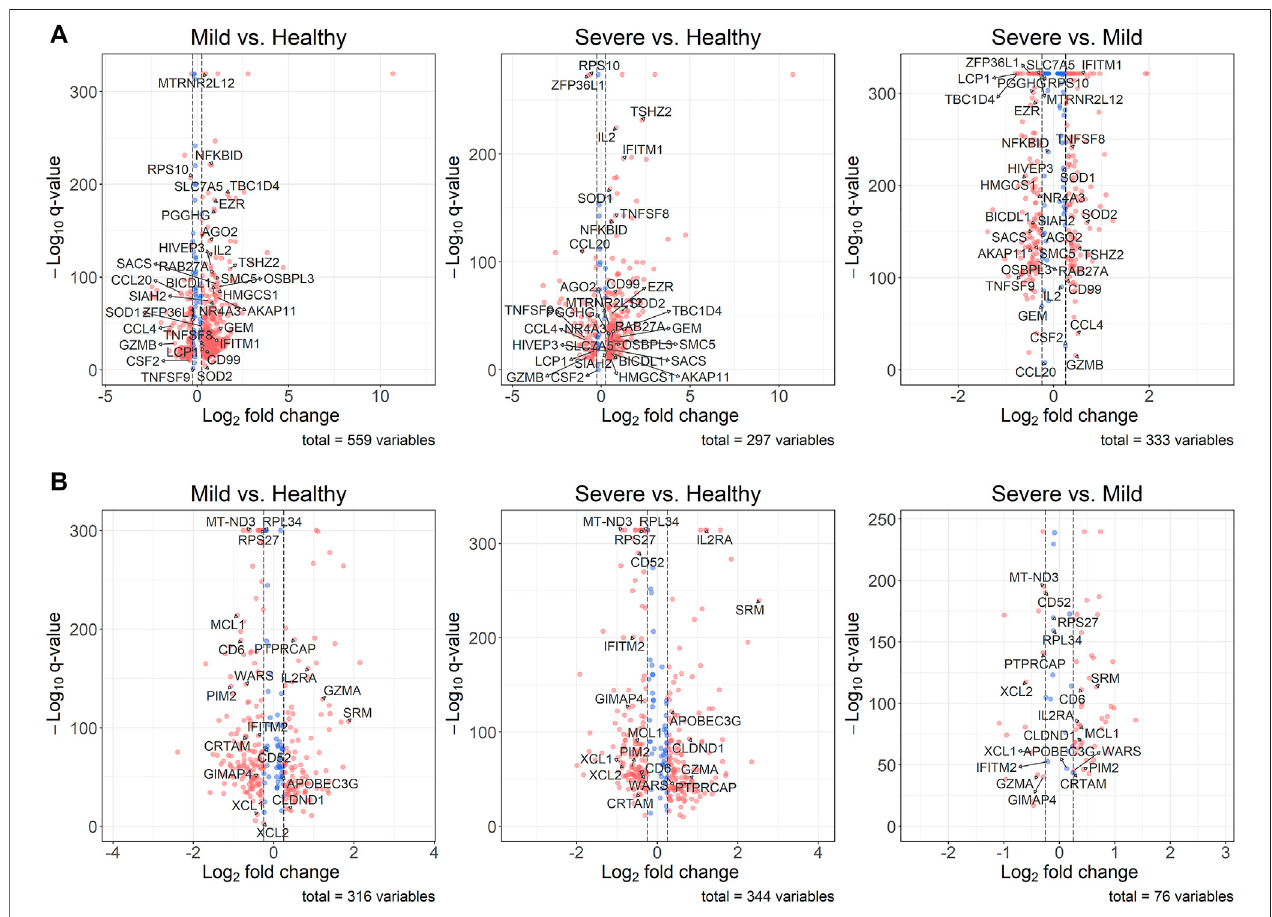
FIGURE3| VolcanoplotsforDEgenes.Thethresholdsoftheabsolutelog 2 FC is0.25 (A) ComparisonsbasedonCD4 + Tcells.DEgenes DDX3Y and EIF1AY have been removed from the mild vs healthy plot and the severe vs healthy plot because of their in fi nite log 2 FC (B) Comparisons based on CD8 + T cells.